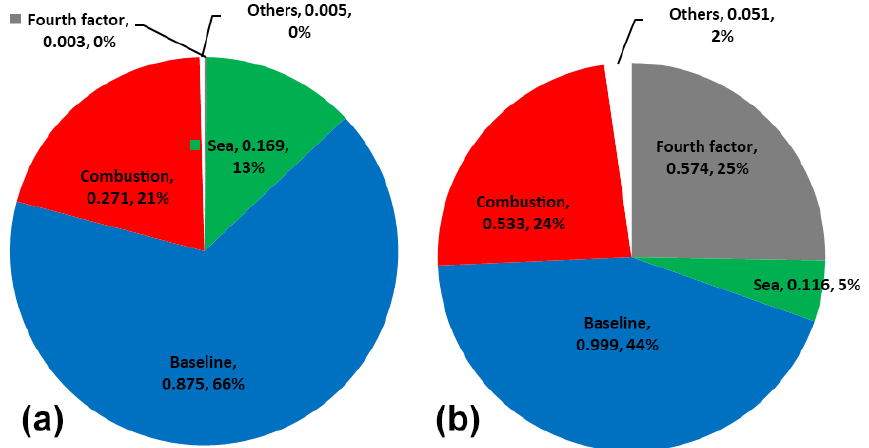
Figure 8. Average contribution (ngm − 3 and %) of Hg 0 factors for Mace Head from 2013 to 2018 (a) and mass closure for mercury concentration greater than 2ngm − 3 (b)